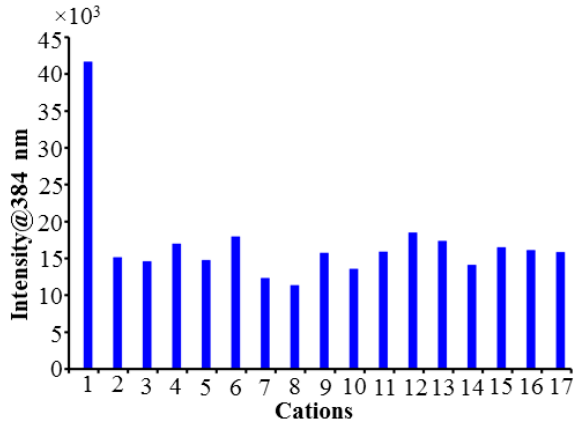
Figure 5. Metal-ion selectivity of receptor 1 towards Fe 3+ ions (10 μ M) in the presence of competitive